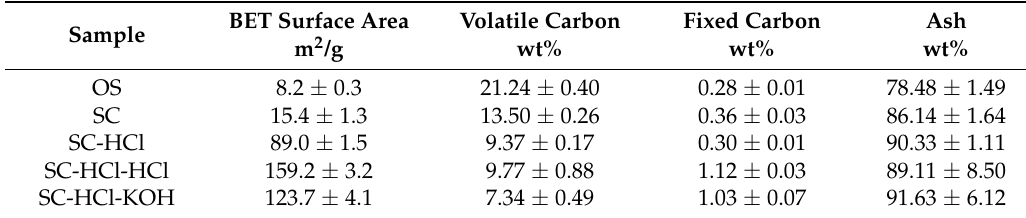
Table 1. Surface area and carbon contents of raw, semi-coke and demineralized samples ( ± 1 standard